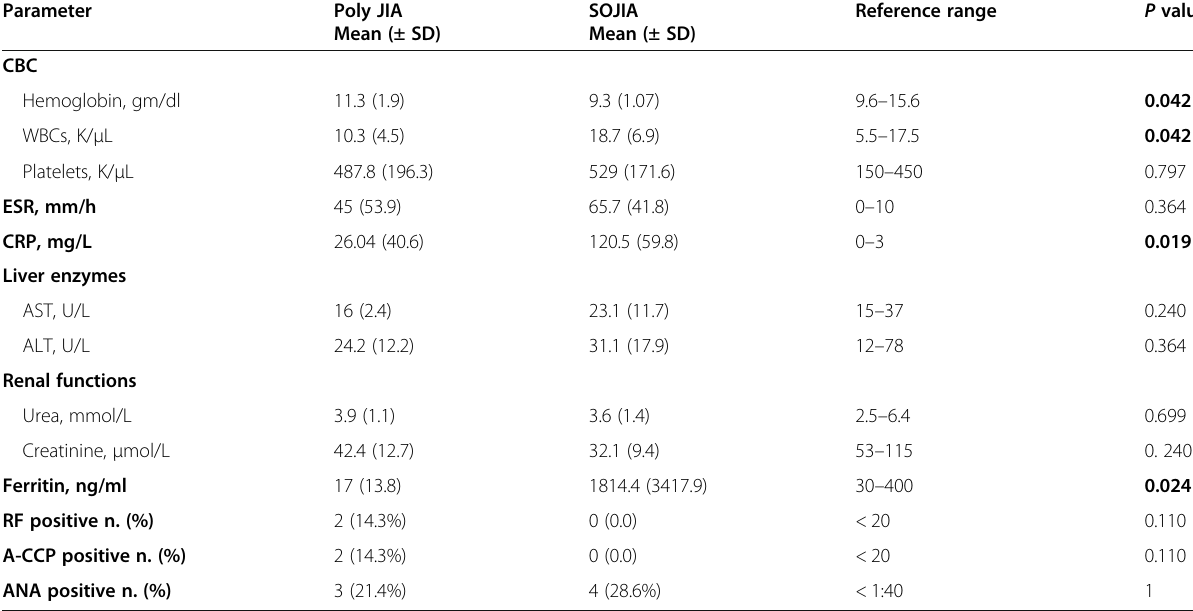
Table 2 Laboratory results of poly JIA and SOJIA Parameter